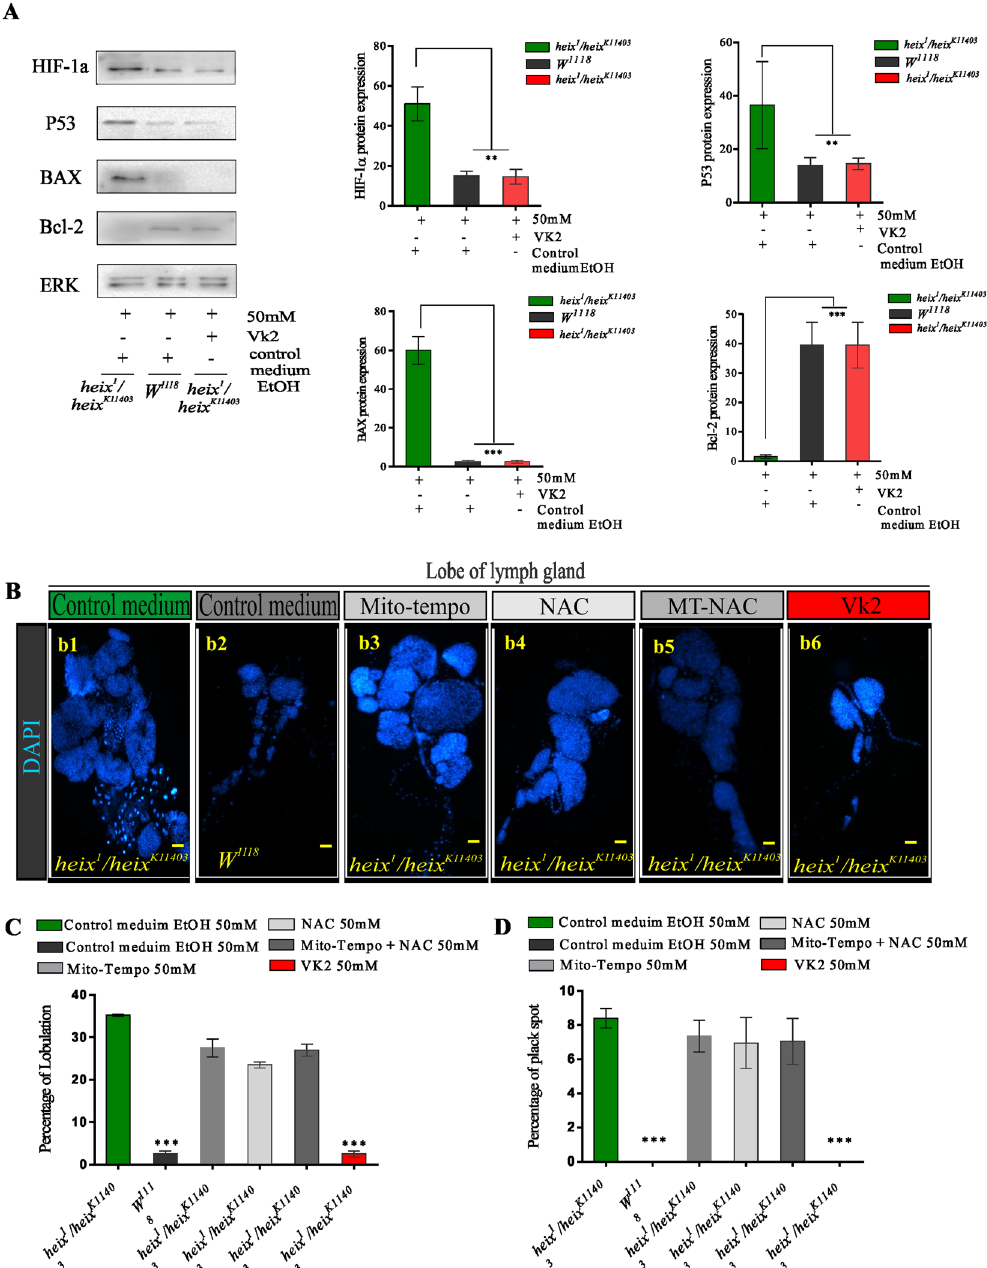
Figure 8. Responses revealed were due to VK2 treatment. Loss of function of heix lead to mitochondrial defects represented by hypoxia. ( A ) Assessment of HIF protein expression by western blot analysis for conformation of hypoxia condition, distinct expression of HIF protein in heix mutants ( heix k11403 /heix 1 ) reared on control medium compared with a significant lesser expression in both control ( Canton S ) and VK2 treated groups. The difference in expression level quite significant. ( A ) Expression of mitochondrial regulator genes ( Bcl2 family), a western blot including Bcl2, Bax , and P53 , there is clear expression of Bax and P53 and fair expression of Bcl2 in heix mutants, all responded to treatment with VK2, and reversed expression was revealed. Response was significant with P53 protein, more significant with both Bax and Bcl2 . ( B ) Treatment of heix mutant larvae with antioxidants N-Acetyl-L-cysteine (NAC) and (Mito-TEMPO) (MT) scavengers in three treatments group design, one with NAC, the other with MT and the third with both of them. heix mutant on control medium with distinct hyperplasia of lymph gland, control ( Canton S ) on control medium with normal lymph gland, heix mutant treated with MT scavenger showed lymph gland hyperplasia, heix mutant treated with NAC scavenger also showed lymph gland hyperplasia, heix mutant treated with MT + NAC scavengers revealed lymph gland hyperplasia, heix mutant treated with VK2 showed normal lymph gland. ( C ) Scavengers didn’t reduce the high lobulation of heix mutant lymph gland as VK2 achieved. ( D ) The percentage of black spots in heix